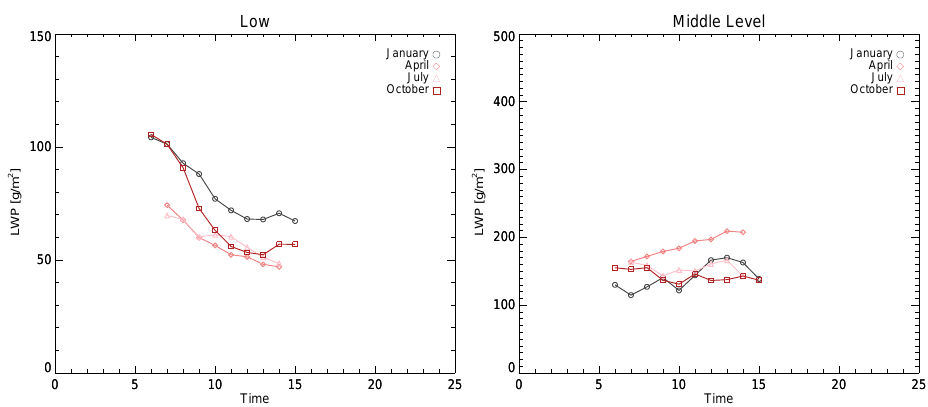
Fig. 7. Average intrinsic diurnal cycle of LWP for 4 months in 2009 for the cloud deck off the coast of Namibia and Angola; left: low clouds; right, middle level clouds. Cloud-free pixels were not included.